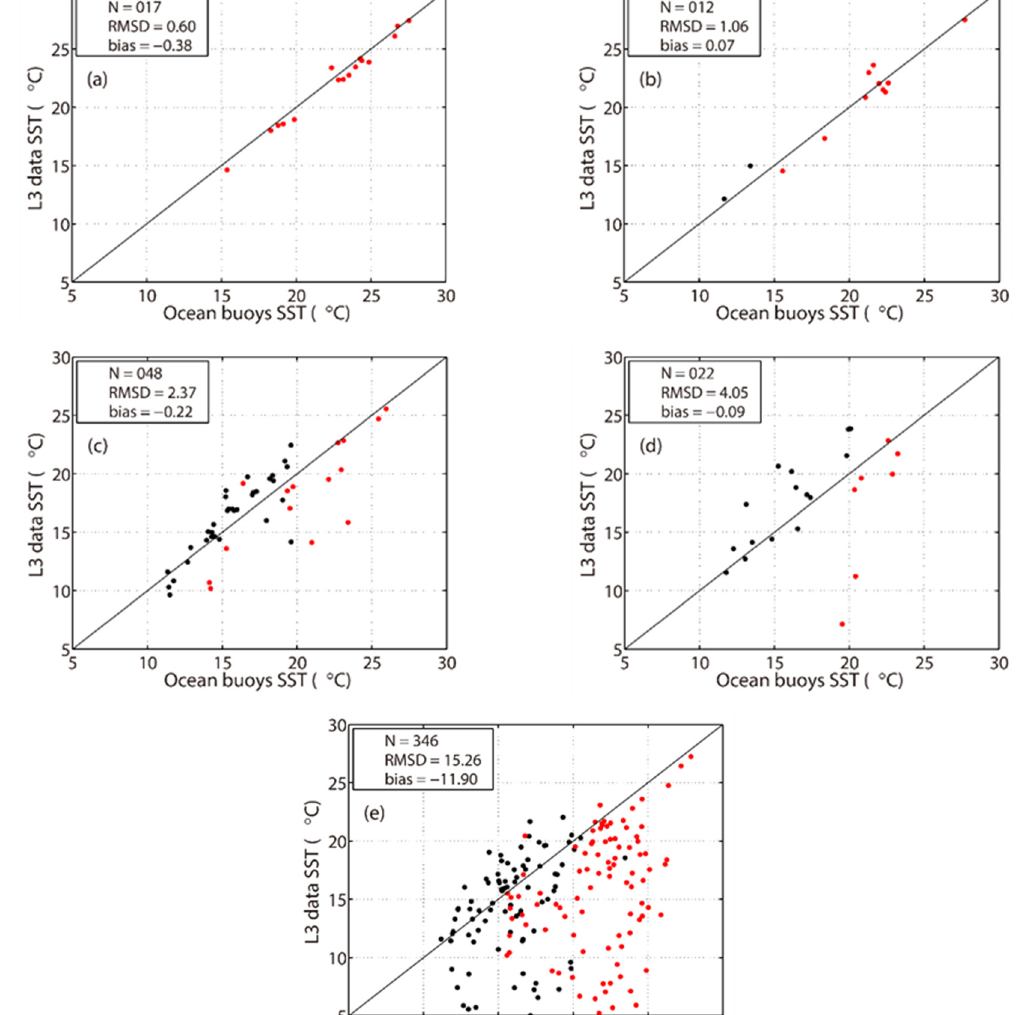
Figure 13. Comparison of the satellite-based L3 SST data with ( a ) best, ( b ) acceptable, ( c ) low, ( d ) bad, and ( e ) worst quality flags and the SST data from ocean buoys D and O in June and July from 2010 to 2013. N is the number of matchup data points. Red and blue dots represent the SST data from ocean buoys O and D, respectively.